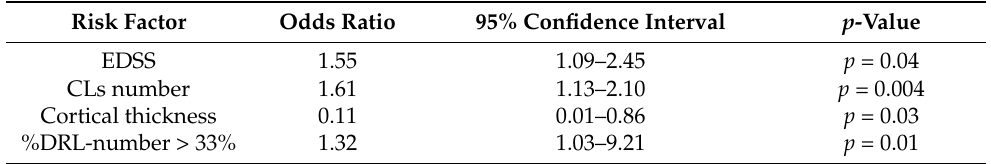
Table 3. Baseline clinical and MRI variables associated with a “significant” EDSS change after 15 years.